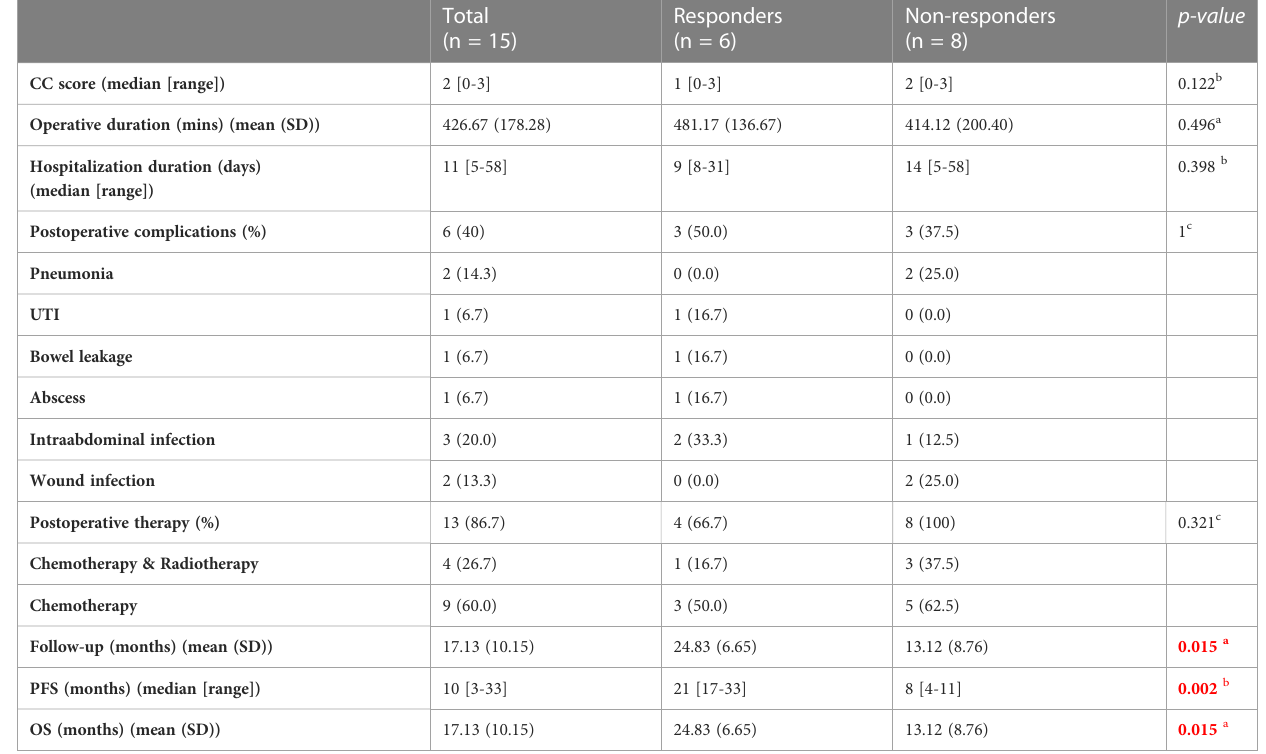
TABLE 2 Operative and postoperative characteristics by response status (*) to